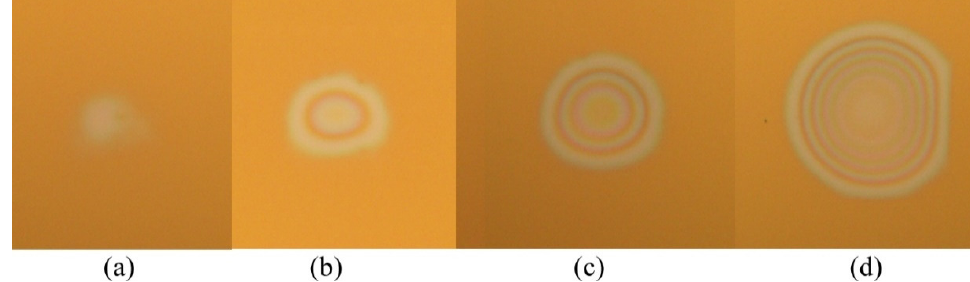
Figure 4. Damage morphology of multilayer film irradiated by femtosecond laser for different fluences. Laser fluences are 1.75 J·cm − 2 ( a ), 1.82 J·cm − 2 ( b ), 1.95 J·cm − 2 ( c ), and 2.26 J·cm − 2 ( d ).